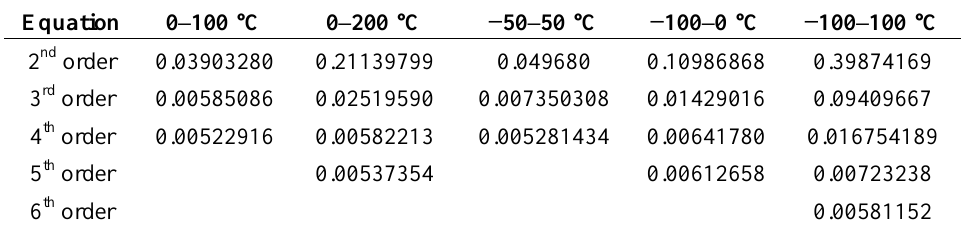
Table 6. Measurement precision of polynomial equations for J-type thermocouples by temperature